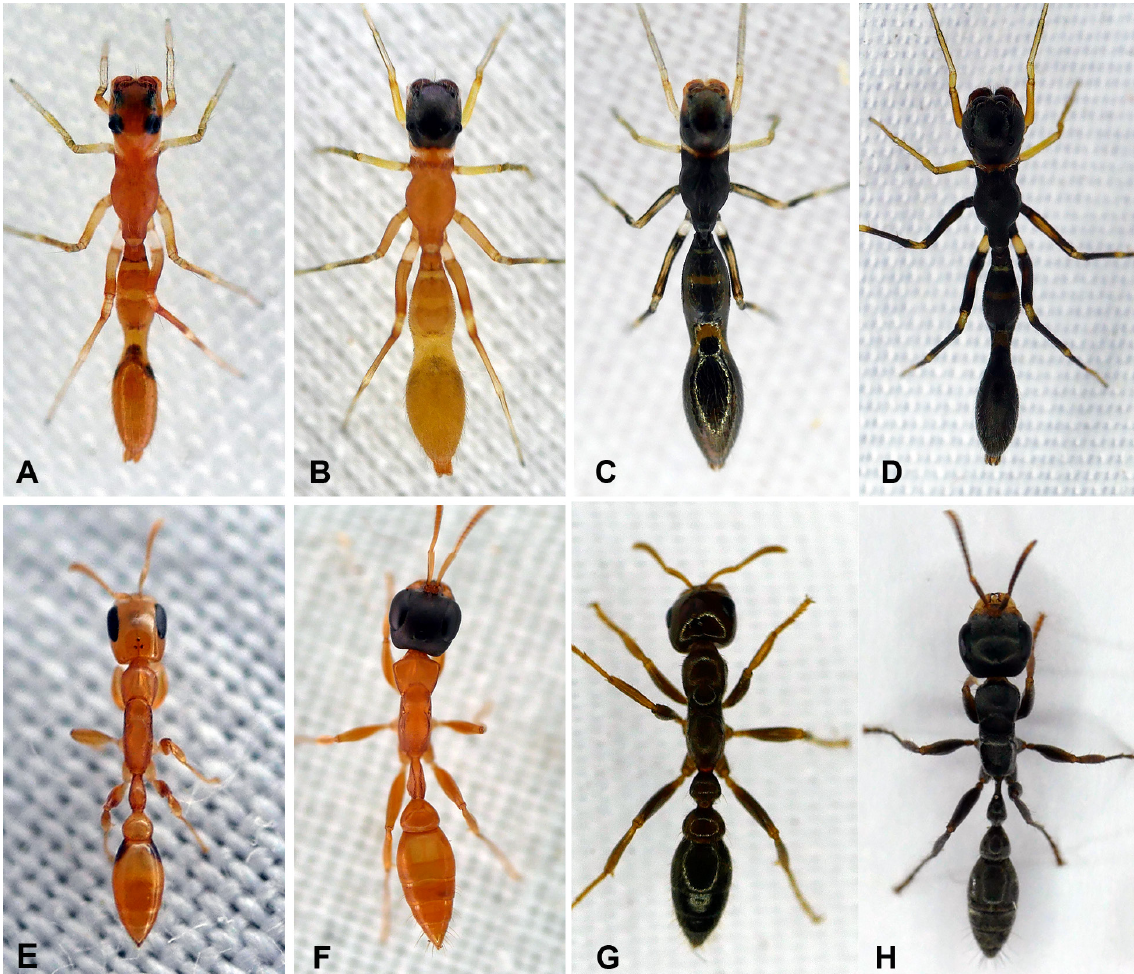
Fig. 8. A–D . Color variants and potential model ants for Synemosyna myrmeciaeformis (Taczanowski, 1871). A . Orange female, Villa Teresa, La Paz Dept. B . Orange female with dark cephalic part,